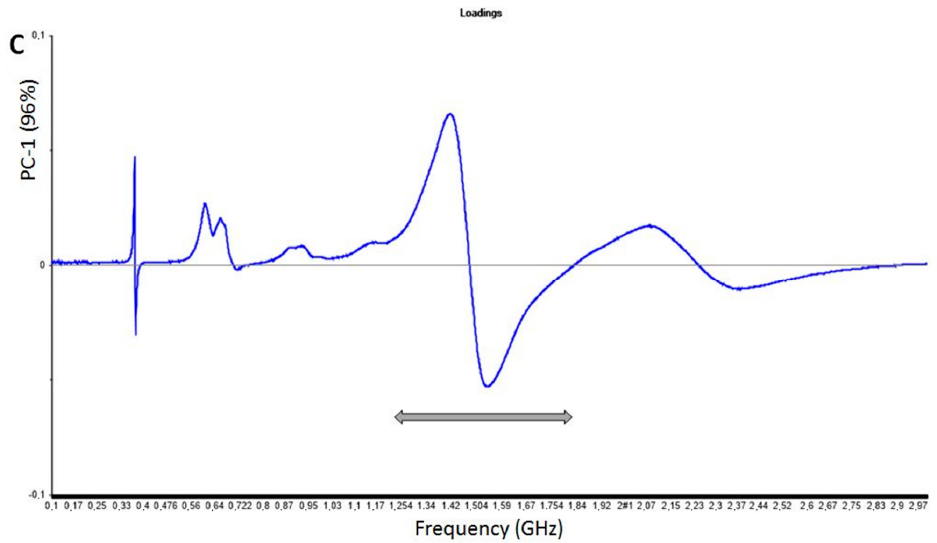
Figure 2. ( A ) Detection of iprodione in model wine medium (water / ethanol, 90 / 10, v / v ). Representative average microwave spectra (100 MHz–3 GHz) generated by a microwave sensor coupled to MIS. Iprodione concentrations varied from 5 to 100 ng.L − 1 . ( B ) Detection of iprodione in model wine medium (water / ethanol, 90 / 10, v / v ) using the microwave sensor coupled to MIS. PCA scores plot of 29 iprodione samples. Each spectrum was normalized by unit vector normalization. ( C ) Detection of iprodione in model wine medium (water / ethanol, 90 / 10, v / v ) using the microwave sensor coupled to MIS. Loading plot for the first principal component (PC1). Characteristic bands are highlighted by a double arrow.